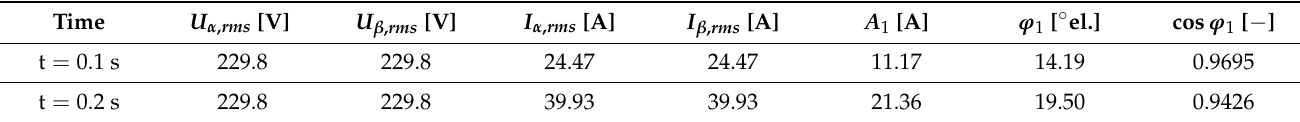
Table 23. Simulation results before and after the change (at steady states).